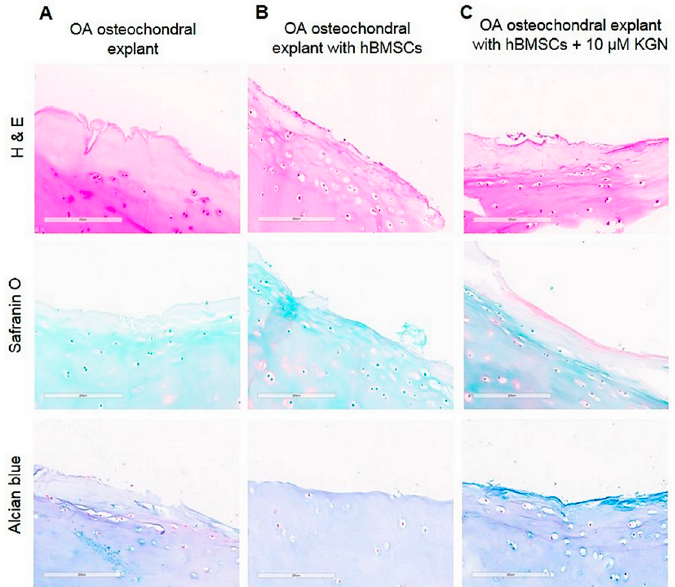
Figure 5. Histologic evaluation of OA cartilage surfaces of ( A ) the explant alone, without cell seeding; ( B ) the hBMSC seeded explant; and ( C ) the hBMSC seeded explant supplemented with 10 µM KGN after in vitro cultivation for 21 days. The scale bar represents 200 µm.